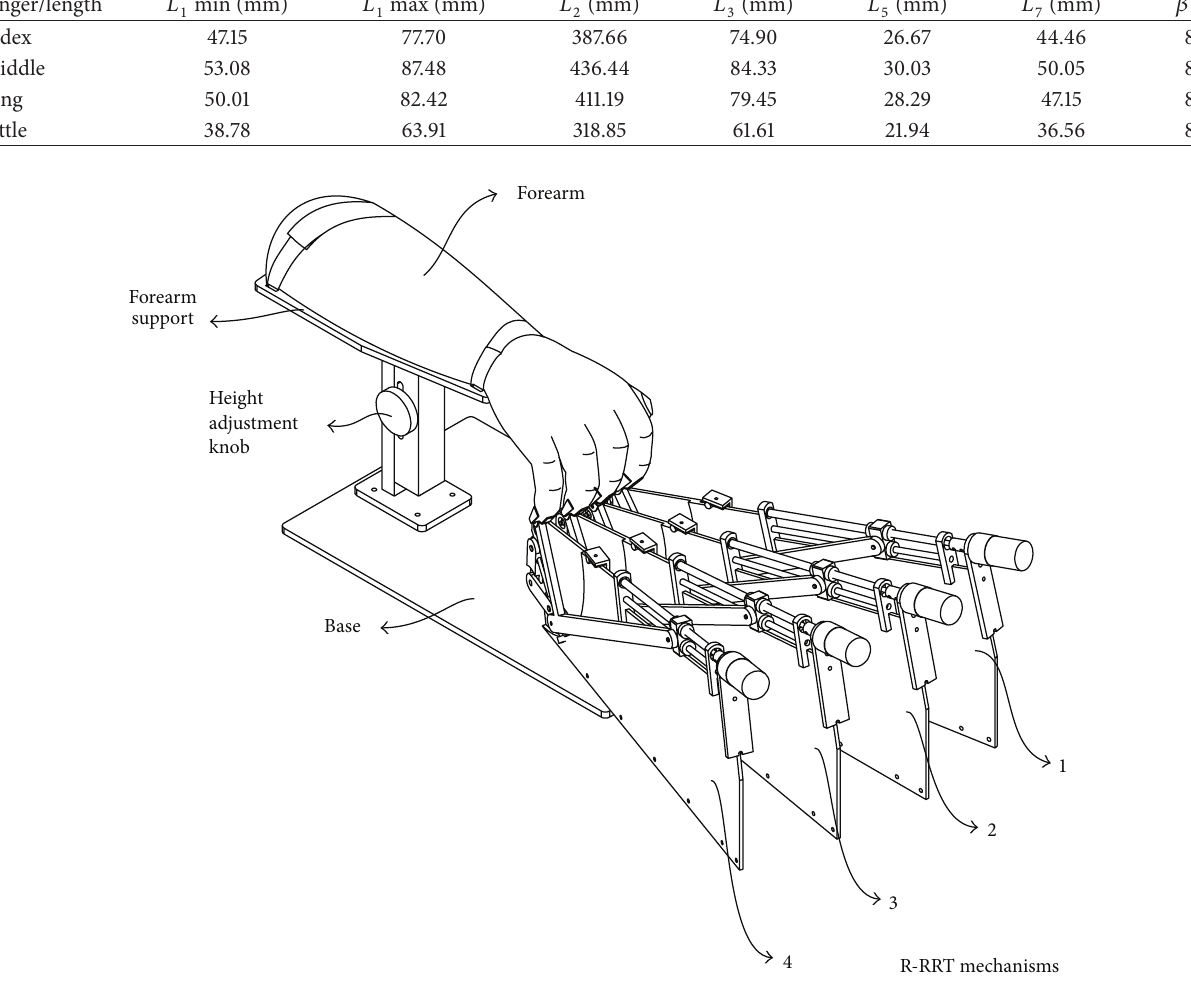
Figure 7: General view of the of the flexoextensor robotic system